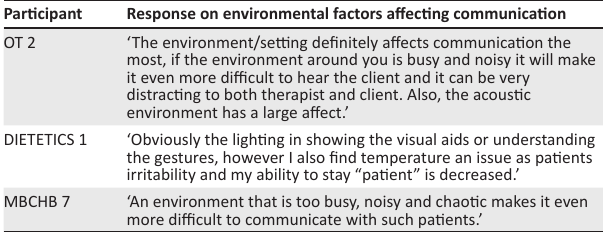
TABLE 3: Factors in the physical environment that affect communication.